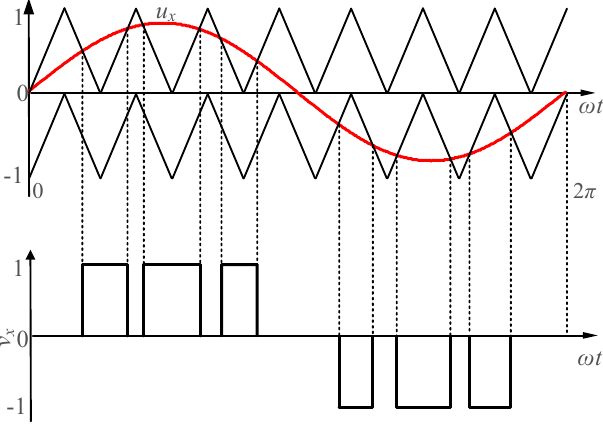
Figure 2. Single polar SPWM method for NPC three-level inverters.